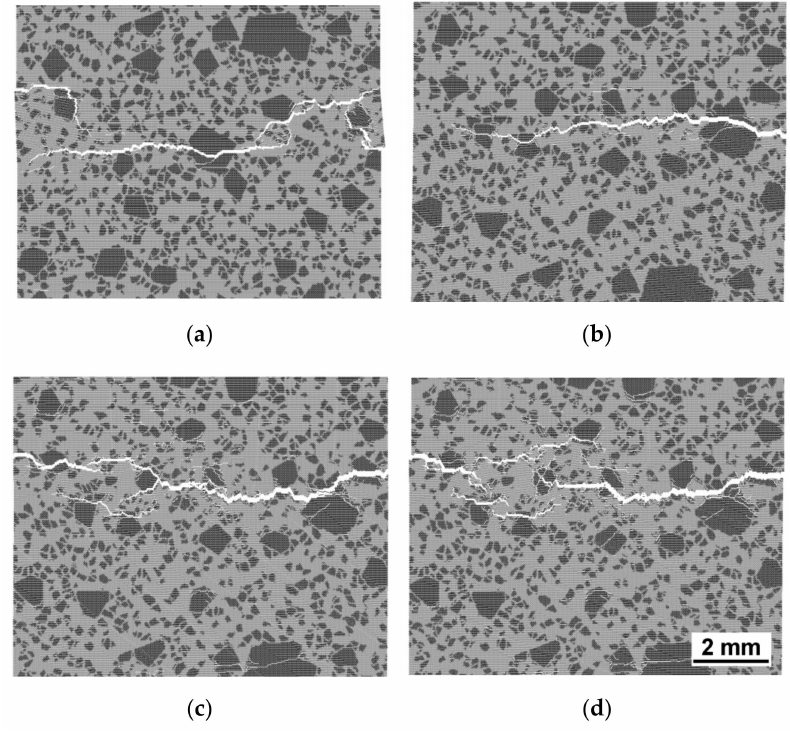
Figure 13. Fracture patterns under dynamic tension for the strain rates of 5 s − 1 ( a ), 10 s − 1 ( b ), 50 s − 1 ( c ), and 100 s − 1 ( d